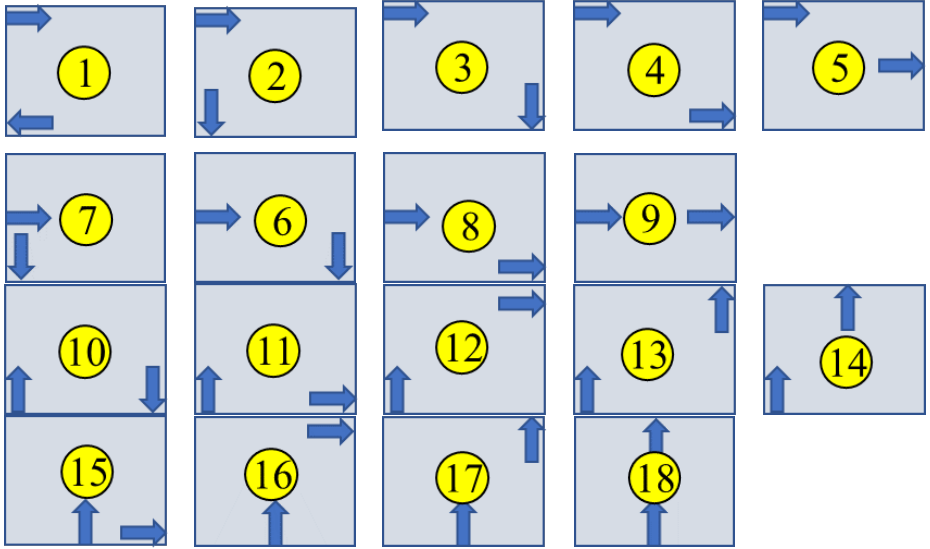
Figure 11. Schemes for the battery pack with a single inlet and single outlet.